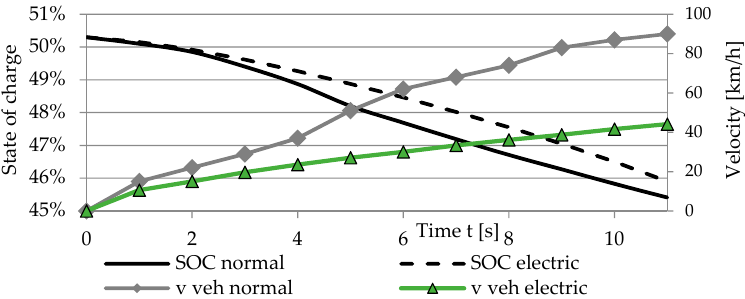
Figure 4. Level of the traction battery charge and vehicle speed versus time.